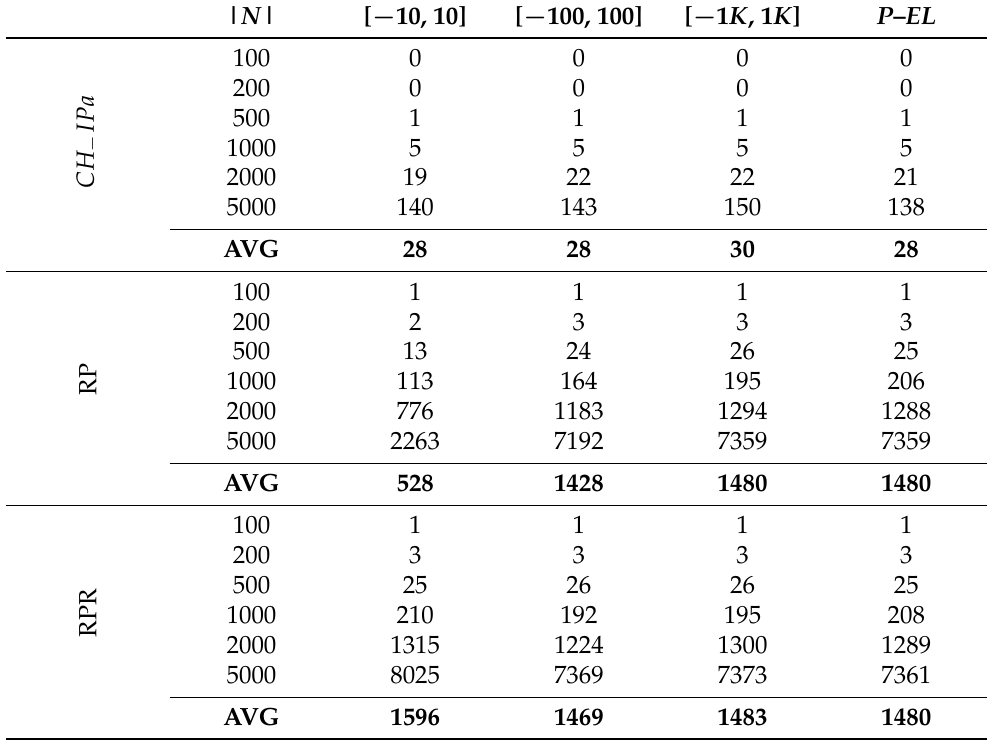
Table 8. Comparison of the CPU time